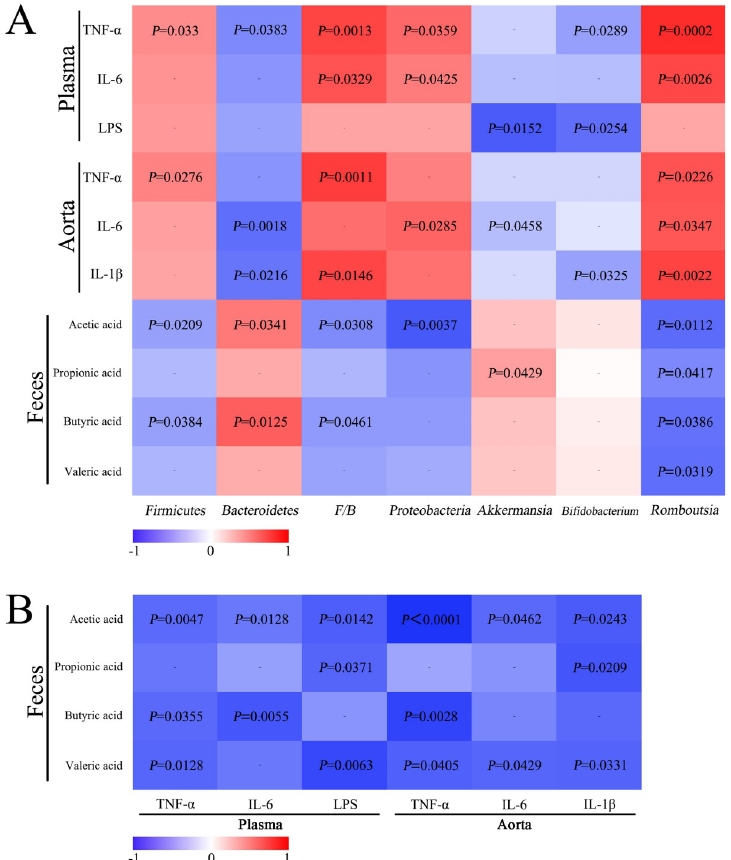
Fig 8. Correlation analysis. (A) Correlations of plasma/aorta inflammatory indicators or SCFAs with relative abundance (%) of gut microbiota; (B) Correlations between SCFAs and inflammatory indicators.